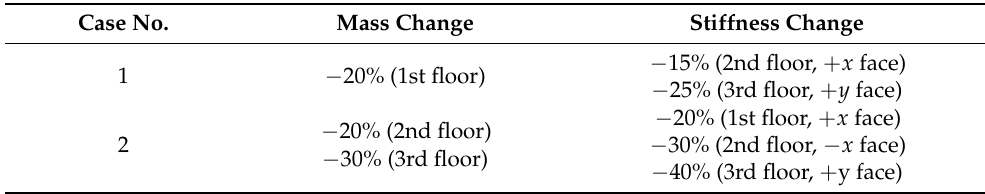
Table 7. Damage cases.